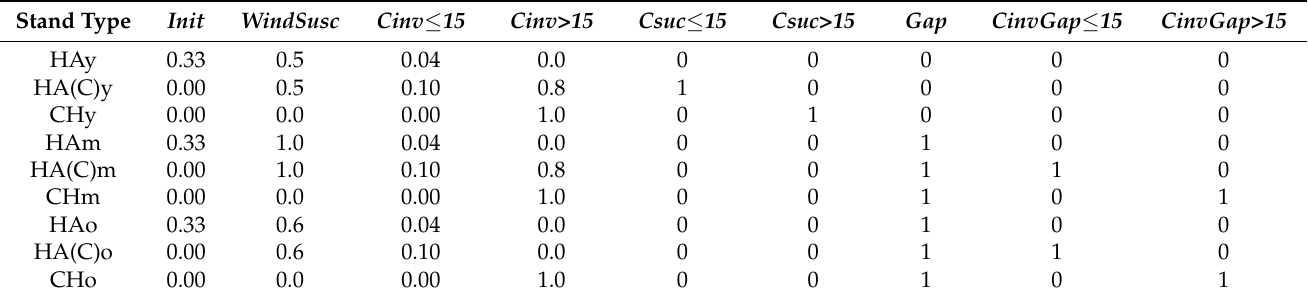
Table 5. Probability values used in the scenario based on opinions from a panel of local experts.